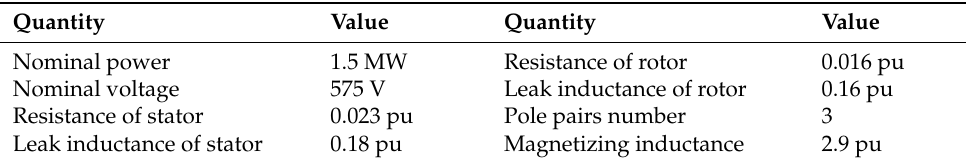
Figure 3. Simulation model of the converter. Table 2. Main parameters of the wind power system.